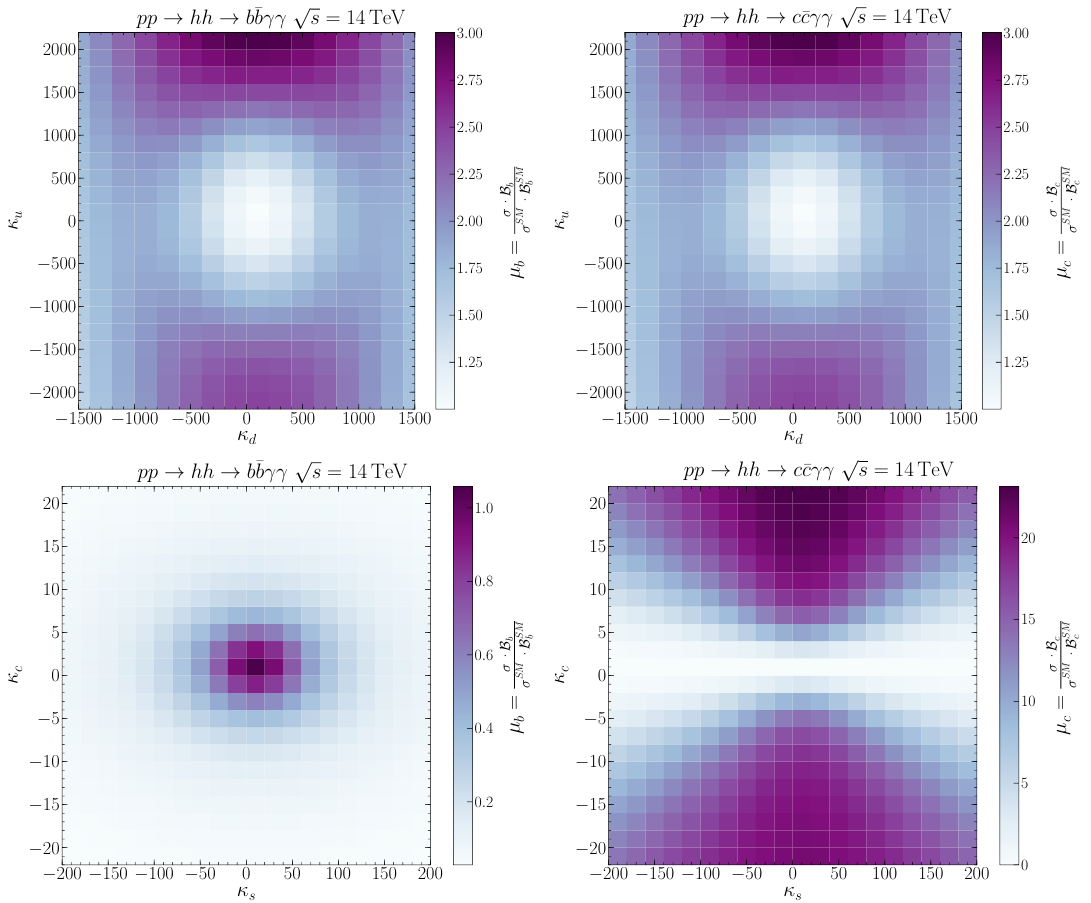
Figure 10 . Signal strength modi(cid:12)er (cid:22) = (cid:27) B ( hh ! X ) = ( (cid:27) SM B SM ( hh ! X )) (cid:12)ts for bottom quark (left plots) and charm quark (right plots) (cid:12)nal states for (cid:12)rst (upper row) and second (lower row) generations quark Yukawa